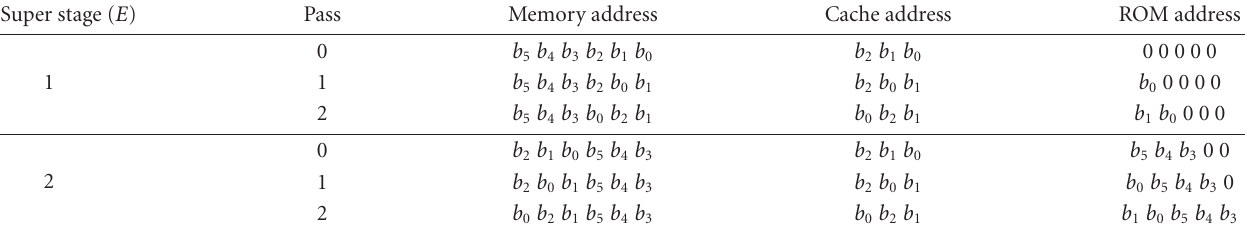
Table 2: Memory and coe ffi cient addresses for a 64-point, r = 2, and E = 2 cached FFT. Super stage ( E )